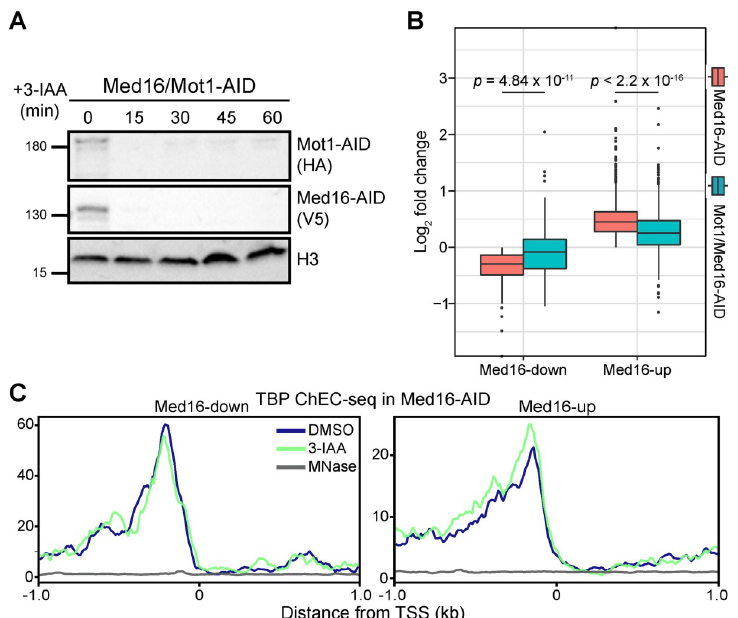
Fig 4. Mot1 removal partially restores wild-type transcription in Med16-AID cells. (A) Western blots showing the kinetics of Mot1-AID and Med16-AID upon 3-IAA treatment of double-degron cells. (B) Boxplots of log 2 fold changes in nsRNA levels of transcripts produced from Med16-down and Med16-up genes for the Med16-AID and Mot1/ Med16-AID 3-IAA versus DMSO comparisons. Statistical differences between groups were assessed by pairwise Wilcoxon rank-sum test with Holm correction for multiple testing. (C) Average plots of TBP ChEC-seq signal ( � 80 bp fragments) from Med16-AID cells treated with 3-IAA or DMSO and free MNase from WT cells (MNase) in a 2 kb window centered around the TSSs of Med16-down and Med16-up